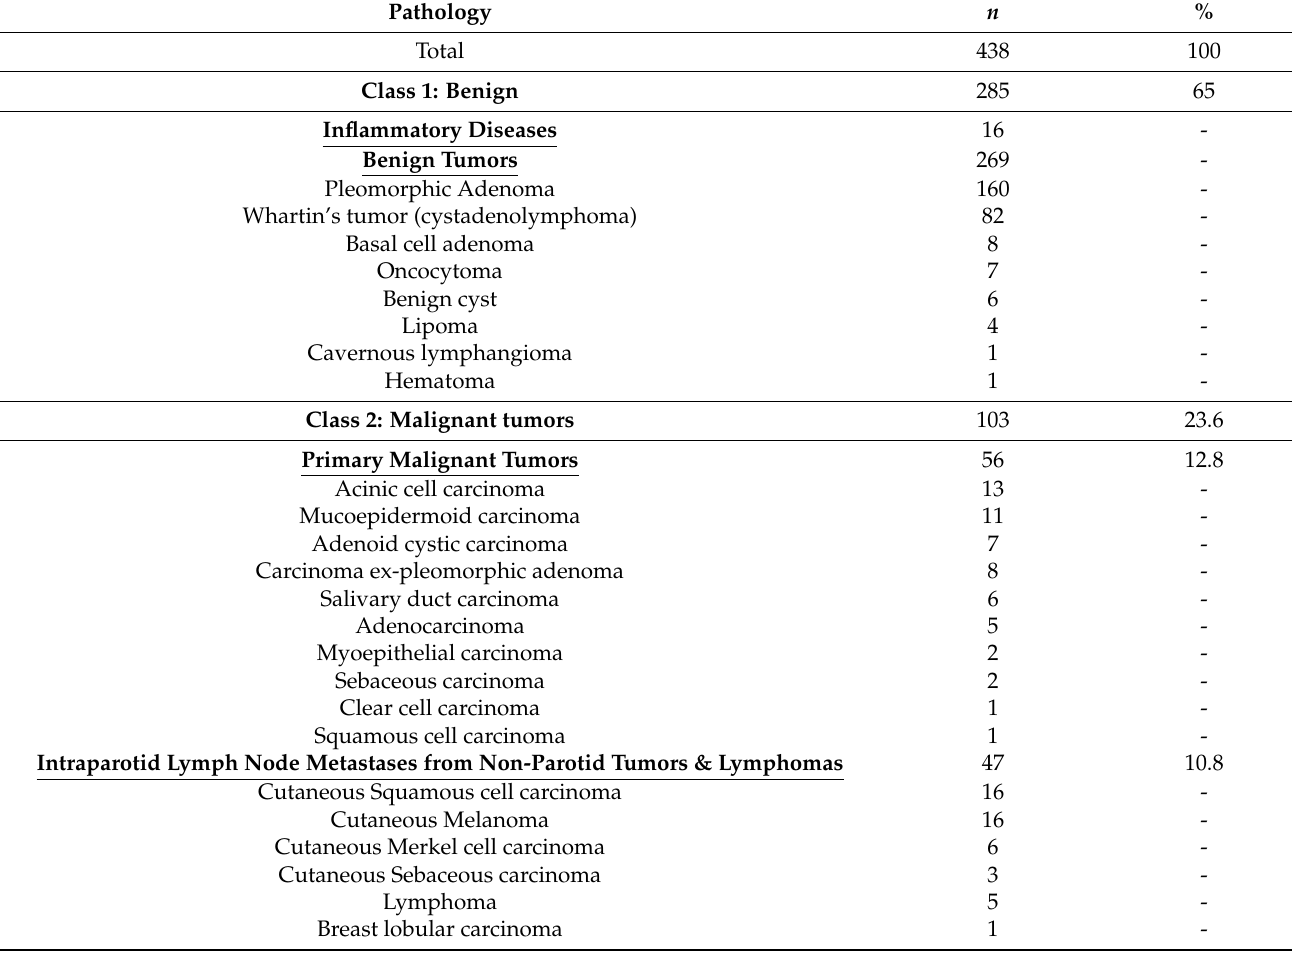
Table 3. Pathology characteristics. Abbreviations: n = number, % =